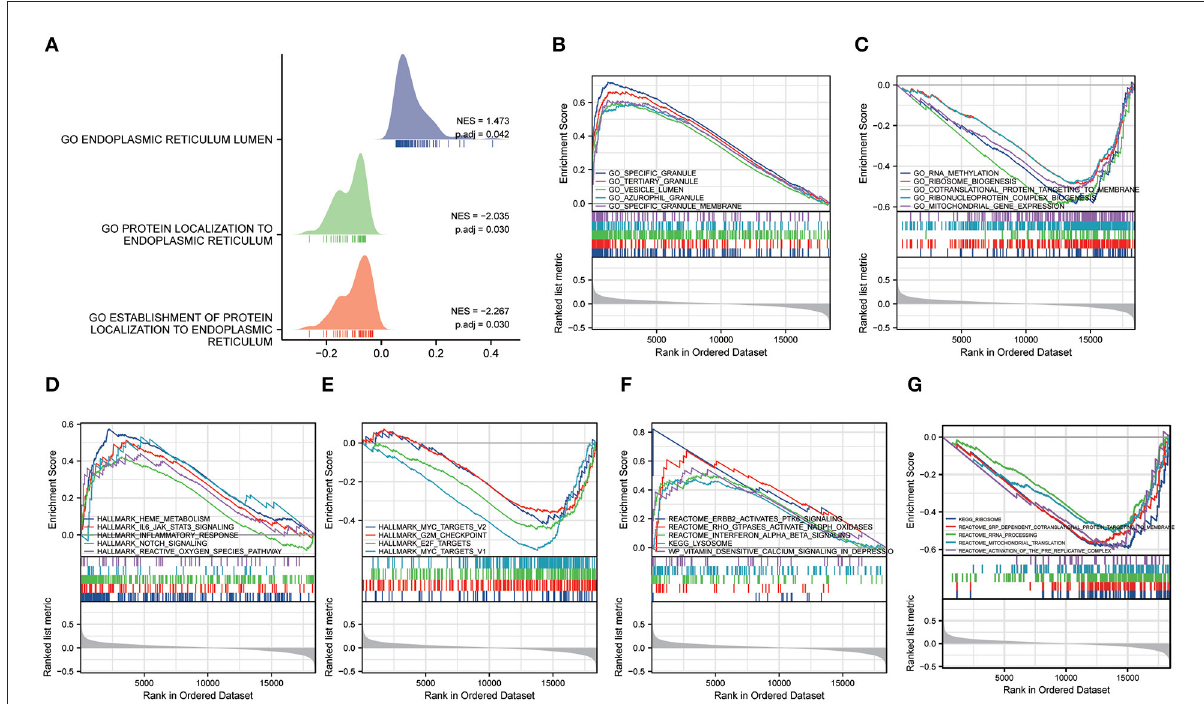
FIGURE7 Gene set enrichment analysis (GSEA). (A) The ridgeline plot of the GSEA illustrates the biological processes associated with endoplasmic reticulum stress in MDD. (B,C) The results of GSEA (GO terms). (D,E) The results of GSEA (Hallmark pathways). (F,G) The results of GSEA (KEGG